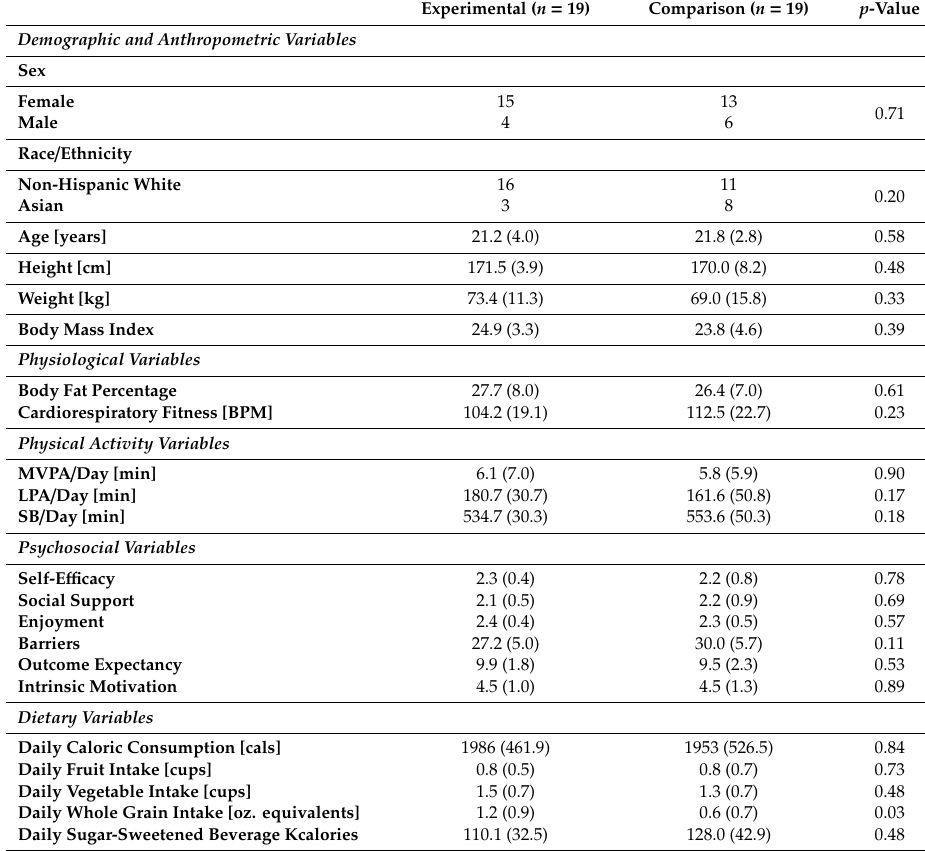
Table 2. Baseline Group